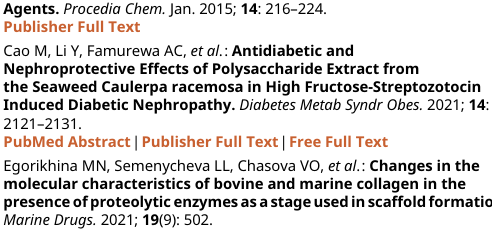
Figshare: Sea grapes powder with addition of tempe rich in collagen: An anti-aging functional